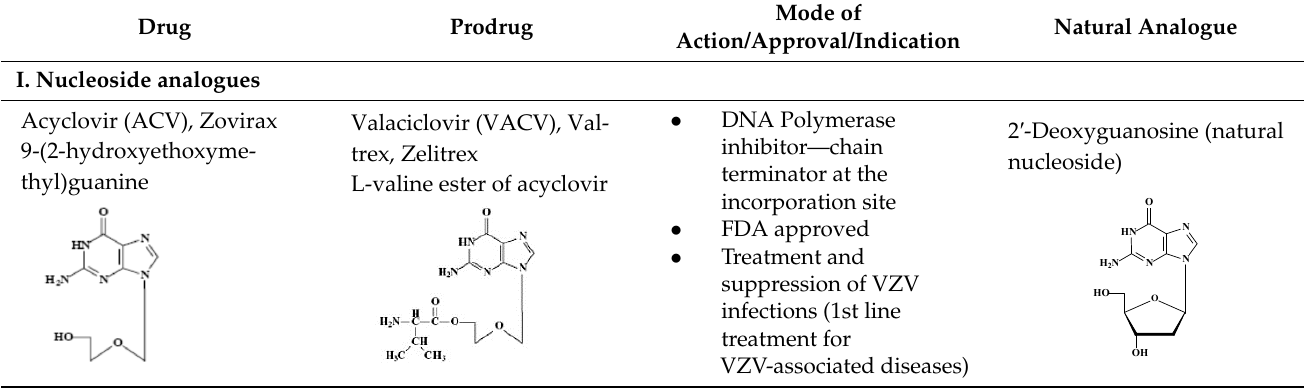
Table 2. Currently licensed anti-herpesvirus agents used to treat VZV infections. Anti-VZV drugs approved in United States, Europe and/or Japan for treatment of VZV-associated diseases and drugs used off label to treat acyclovir-resistant Table 2. Currently licensed anti ‐ herpesvirus agents used to treat VZV infections. Anti ‐ VZV drugs approved in United Table 2. Currently licensed anti ‐ herpesvirus agents used to treat VZV infections. Anti ‐ VZV drugs approved in United Table 2. Currently licensed anti ‐ herpesvirus agents used to treat VZV infections. Anti ‐ VZV drugs approved in United States, Europe and/or Japan for treatment of VZV ‐ associated diseases and drugs used off label to treat acyclovir ‐ resistant infections. States, Europe and/or Japan for treatment of VZV ‐ associated diseases and drugs used off label to treat acyclovir ‐ resistant States, Europe and/or Japan for treatment of VZV ‐ associated diseases and drugs used off label to treat acyclovir ‐ resistant infections. infections.